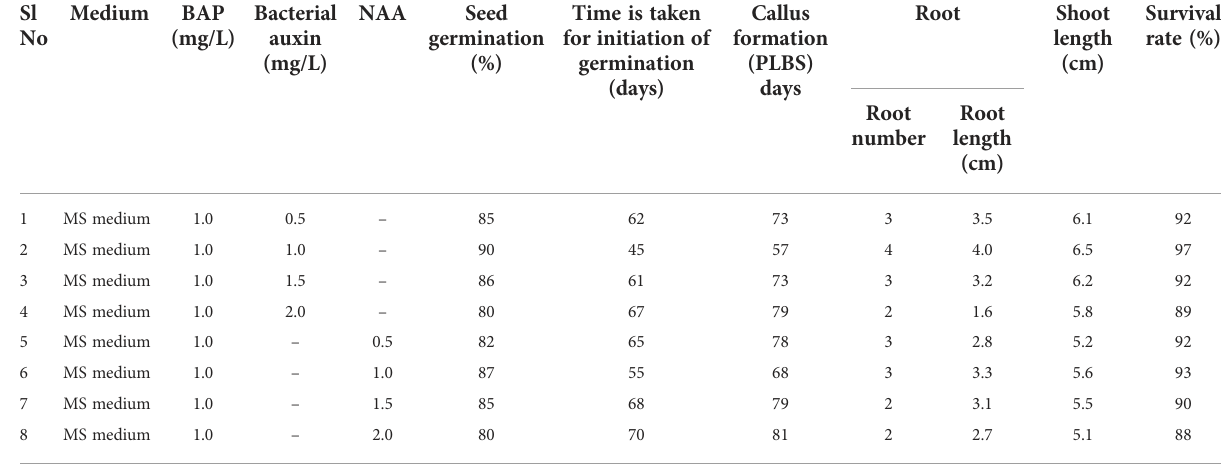
TABLE 2 The biological effect of bacterial auxin on orchid ( Cymbidium aloifolium ) seed germination and root induction.